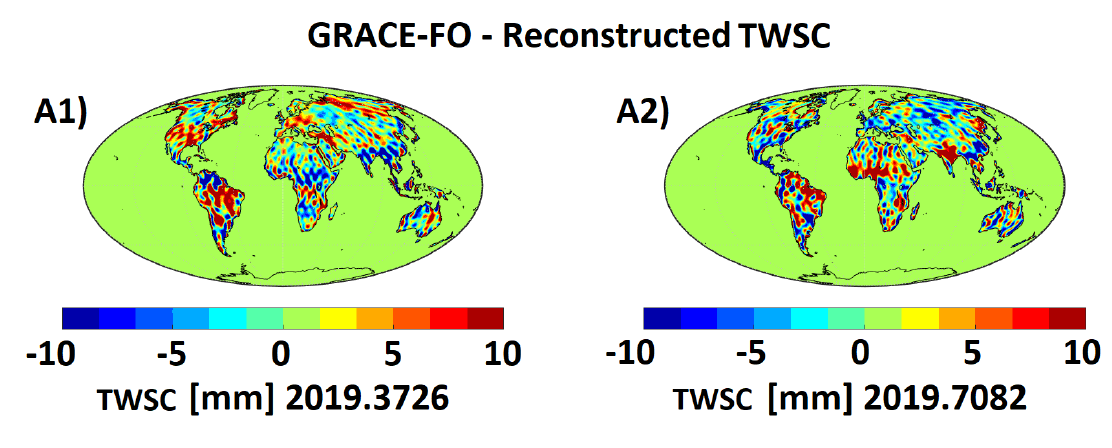
Figure 5. Differences between GRACE-FO TWSC–terrestrial water storage changes fields and the reconstruction results of Approach 2 in ( A1 )) 2019.3726 (April 2019) and ( A2 )) 2019.7082 (August 2019), respectively. A mask is used to retain the signal over the